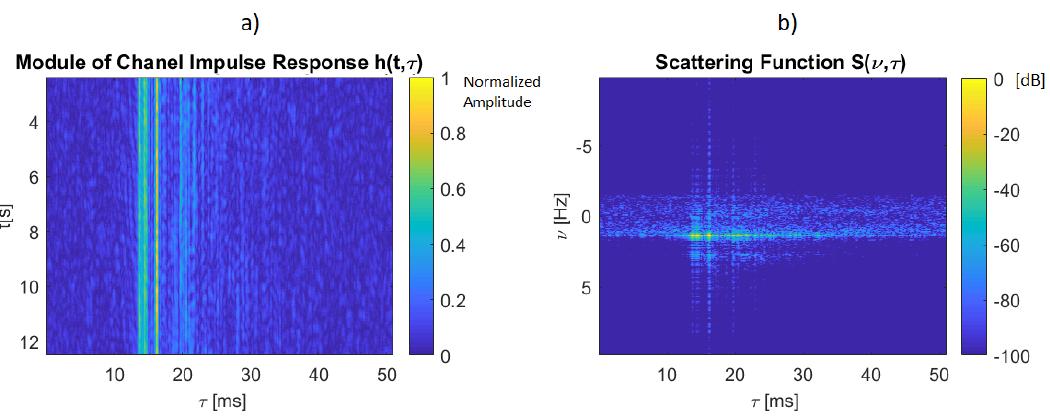
Figure 4. Module of TVIR ( a ) measured at a distance of 1035 m and corresponding scattering function ( b